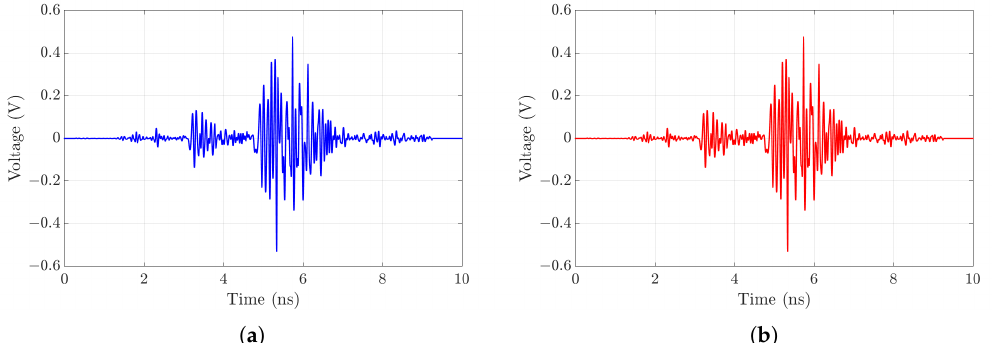
Figure 15. Comparison between the differences of the reflected voltage generated by the far anti- dipole Vivaldi antenna from simple large blades without cracks, with one crack, and with two cracks: ( a ) the distinctions between an intact and a cracked blade; ( b ) the distinctions between an intact blade and a two-cracked blade.